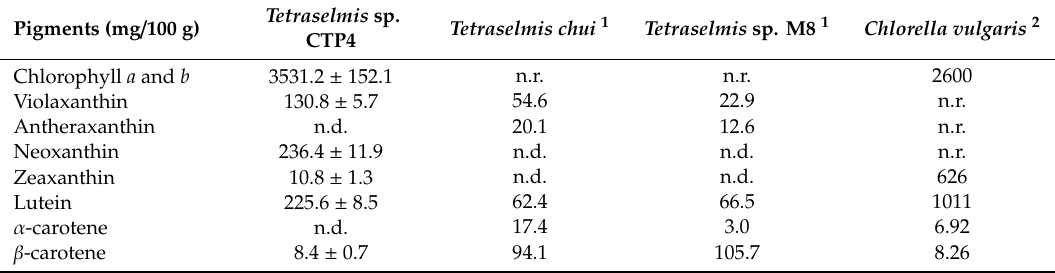
Table 4. Pigment profile of Tetraselmis sp. CTP4 grown semi-continuously in industrial tubular photobioreactors (mg / 100 g). Values represent the mean and corresponding standard deviation ( n = 3). Values from the literature for Tetraselmis chui , Tetraselmis sp. M8, and Chlorella vulgaris are also presented. n.d.—not detected; n.r.—not